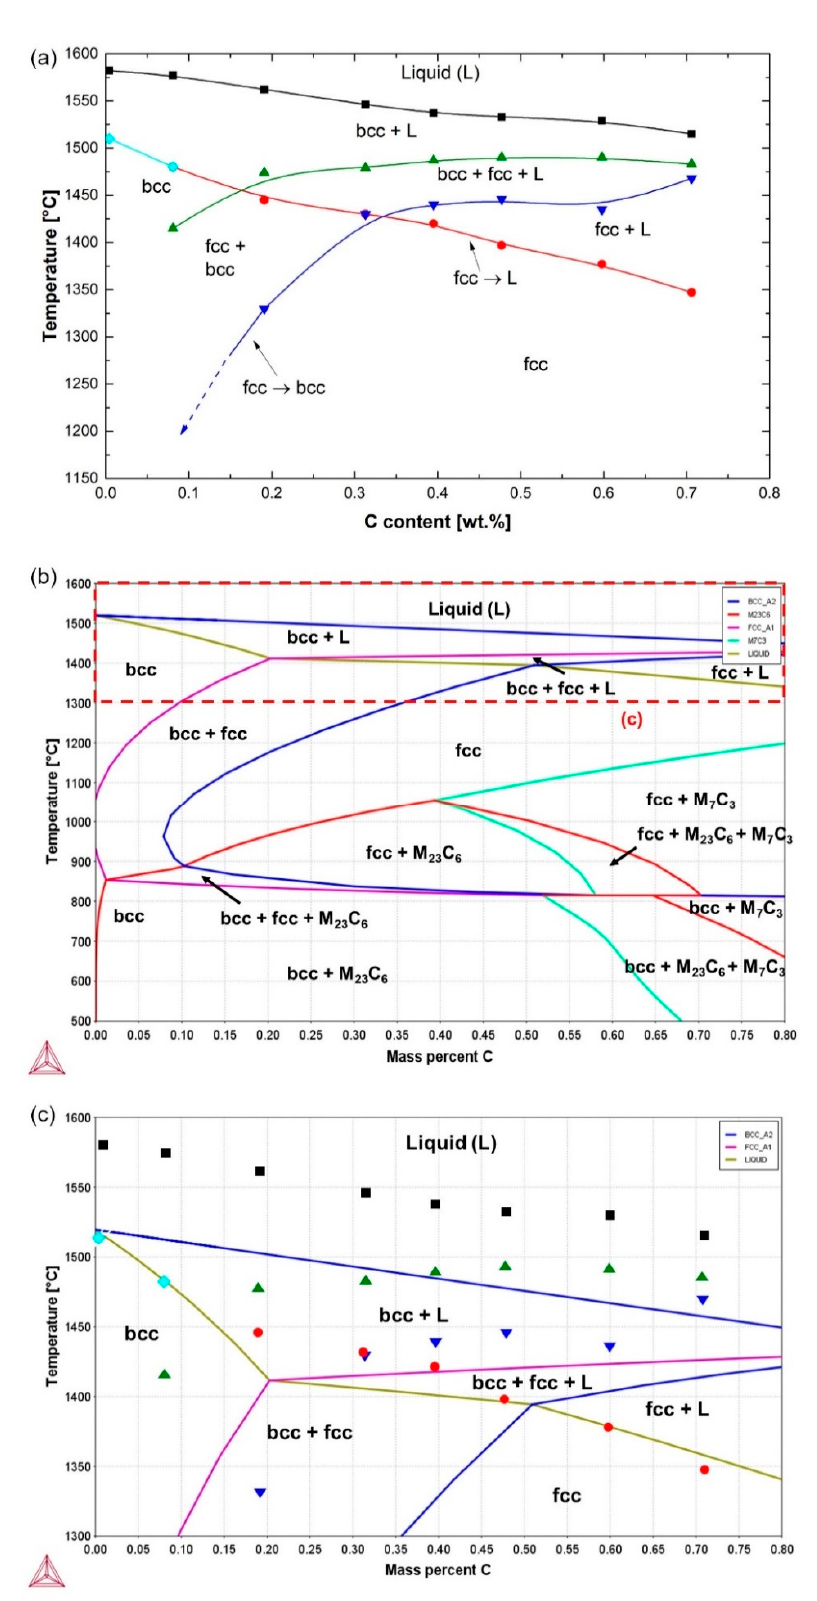
Figure 3. Comparison of the phase transformation temperatures determined based on the DSC signal during continuous heating ( a ) and the results calculated with Thermo-Calc ( b ). ( c ) shows a magnified view of the area marked by a dashed rectangle in ( b ). The DSC-based transformation temperatures marked in ( a ) are superimposed in ( c ).